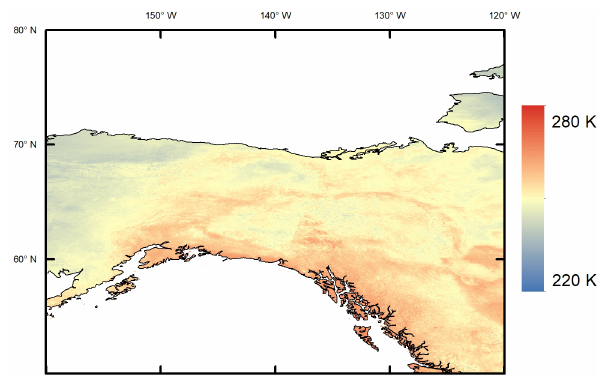
Figure 12. Case showing the artificial texture (middle of the image) in northwestern Canada at 05:00UTC on 2 January